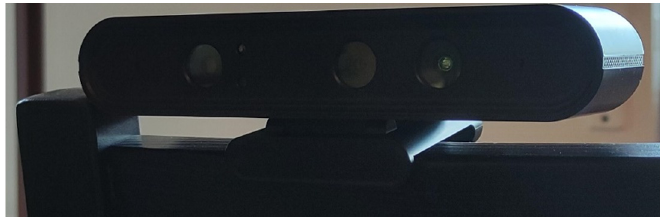
Figure 5. Camera Astra